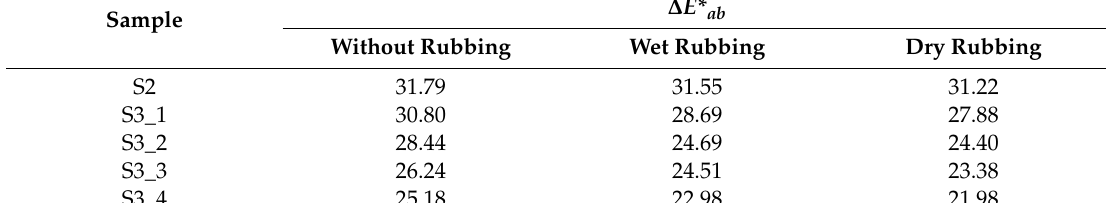
Table 6. Colorfastness to rubbing of studied samples.